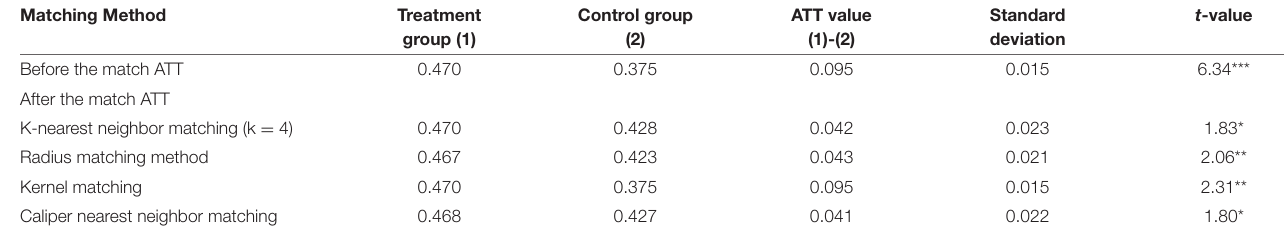
TABLE 5 | The average treatment effect of Internet use on self-rated